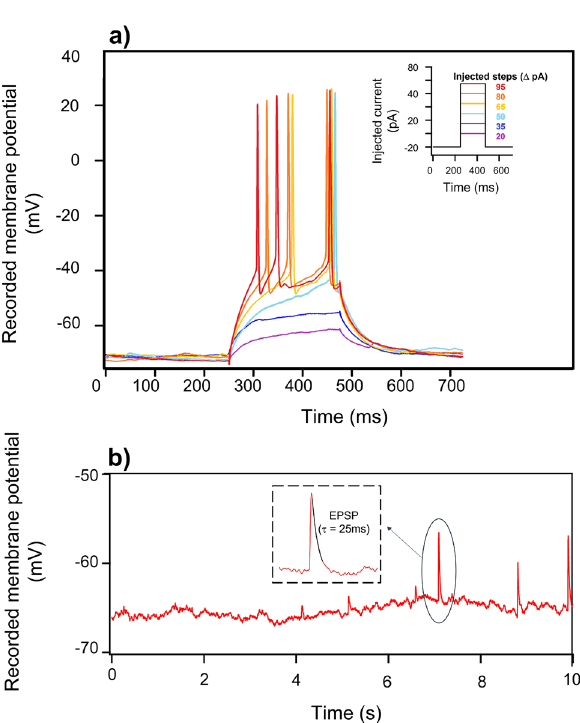
Figure 6. ( a ) Elicited action potentials from primary hippocampal neurons plated on the nanostructured diamond substrate. The curves are obtained by injecting discrete, incremental, depolarizing current pulses close to threshold. Action potentials present a clear overshoot and hyperpolarization phase. ( b ) Excitatory post synaptic potentials (EPSPs) produced at −65 mV membrane potential by spontaneous synaptic activation. In the inset a single ESPS peak is fit giving a time decay constant τ ∼ 25